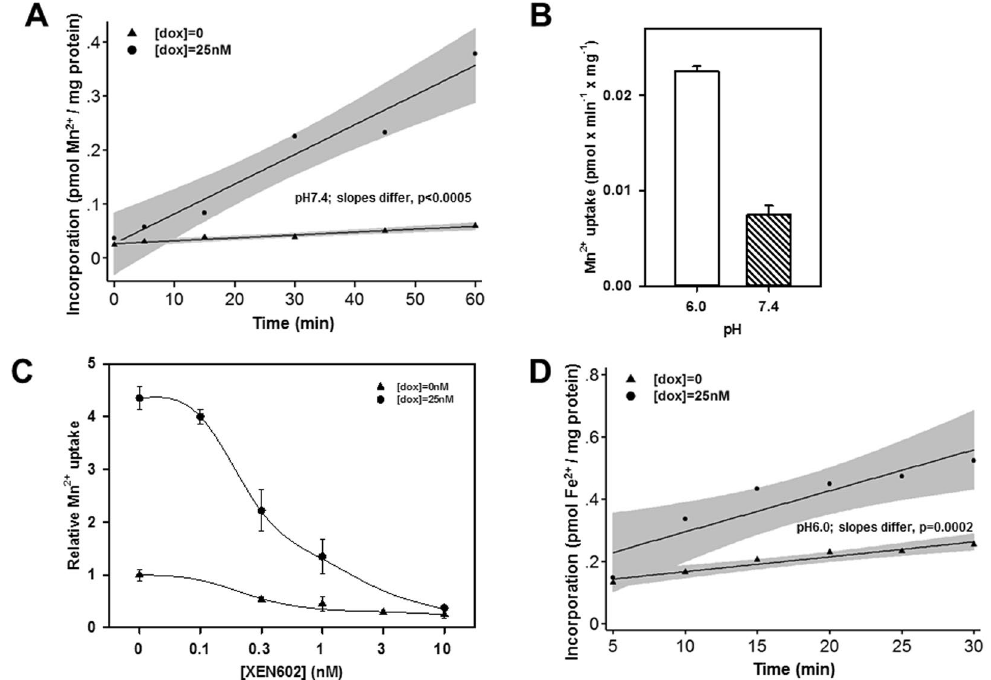
Figure 6. Mitochondrial Mn 2 + and Fe 2 + uptake in rDMT1-overexpressing HEK293 cells is consistent with DMT1.Mitochondria were isolated from uninduced ([dox] = 0) or induced ([dox] = 25 nM) rDMT1-HEK293 cells for all 4 panels. ( A) Time course for Mn 2 + uptake. Mitochondria were exposed to 0.5 µ M 54 Mn 2 + at pH 7.4 and incorporation determined as described in the Methods. Lines were fitted by regression; shading indicates 95% confidence intervals. This plot is representative of 3 separate experiments after which all remaining 54 Mn 2 + experiments were at pH 6.0. ( B ) pH dependence of Mn 2 + uptake. Mitochondria were exposed to 0.5 µ M 54 Mn 2 + at pH 6.0 and 7.4 then incorporation was determined like in ( A ). Only mitochondria from cells exposed to 25 nM doxycycline were analysed. The slope for each plot and the standard error of the estimate (SEE) for the slope were calculated as in ( A ) then plotted as Mn 2 + uptake and error bars for these values. This plot is representative of 2 separate experiments. ( C ) Inhibition of mitochondrial Mn 2 + incorporation by XEN602, a specific DMT1 inhibitor. Mitochondria were exposed to 0.5 µ M 54 Mn 2 + at pH 6.0 and incorporation determined like in ( B ) except that incubations included XEN602 concentrations as indicated. The slope for each plot and the SEE for the slope were calculated as in ( A ) then plotted here as relative Mn 2 + uptake with uninduced and uninhibited uptake (1.8 pEq Mn × min − 1 × mg − 1 protein) set as 1.0 and error bars for these values. This plot is representative of 2 separate experiments. ( D ) Time course for Fe 2 + uptake. Mitochondria were exposed to 2 µ M 59 Fe 2 + at pH 6.0 and incorporation was determined as described in the Methods. Lines were fitted by regression; shading indicates 95% confidence intervals. This plot is representative of 6 separate